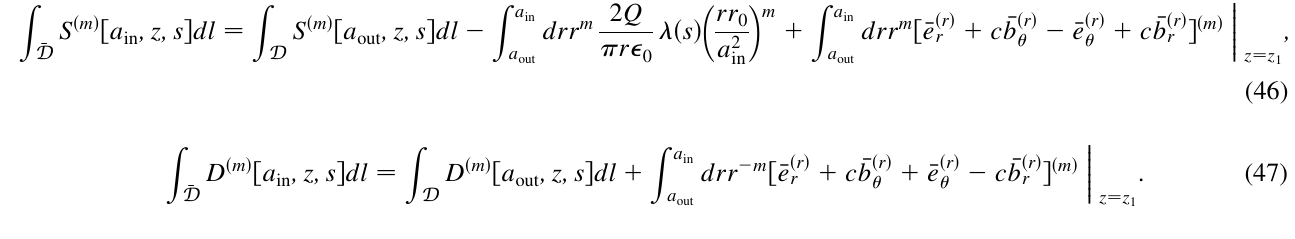
FIG. 3. (Color) The cavity and the integration path. A closed loop H consists of a straight line D and (cid:1) D and the two radial lines connecting between them at z (cid:1) (cid:9)1 and z (cid:1) z of contour (cid:9) (cid:1) D means that the direction of the integration path is opposite to (cid:1) D . The contour H defines the loop path described in the red